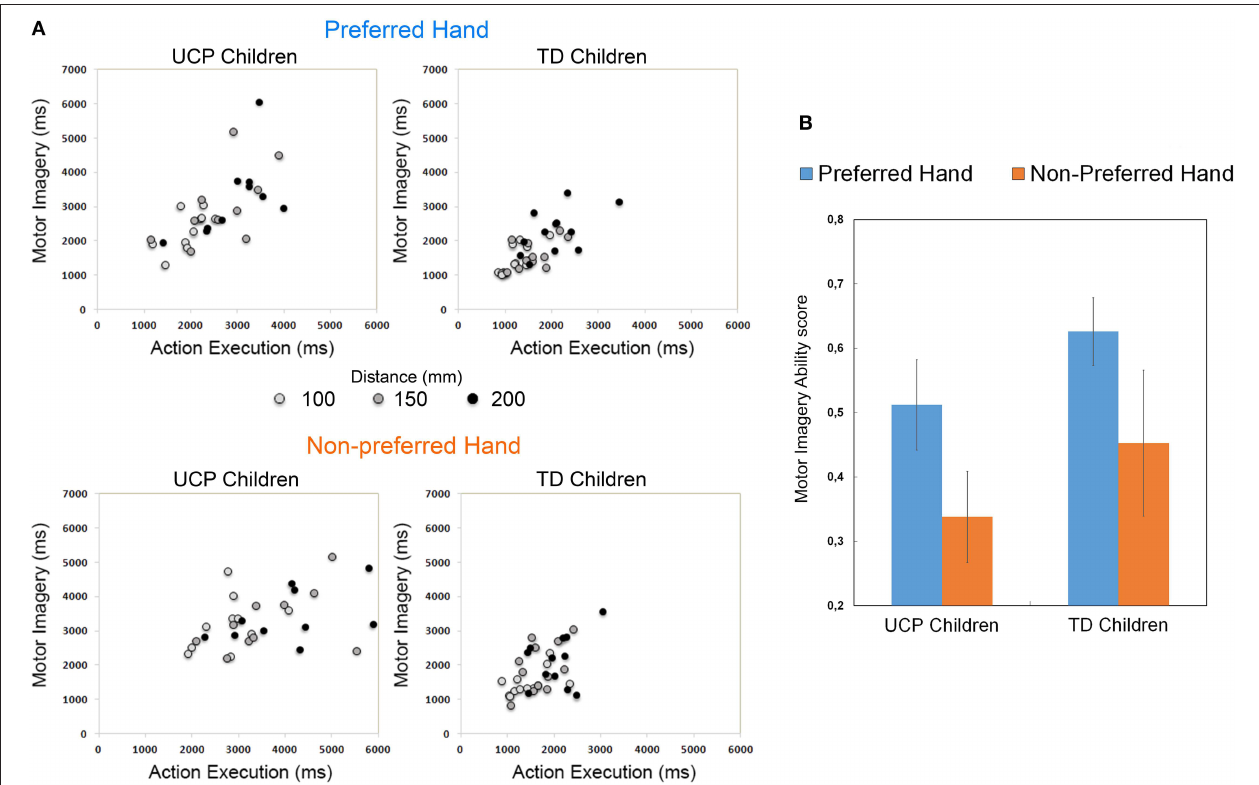
FIGURE 3 | (A) Scatterplot showing correlations between movement durations (ms) in the Action Execution and Motor Imagery conditions performed by each group of participants, using the preferred and the non-preferred hand. The lighter dots represent the trials with the shortest distance, the darker dots those with the longest distance. (B) Histogram shows the Motor Imagery Ability (MIA) scores, calculated as correlation (Pearson coefficient) index between movement times under Action Execution and Motor Imagery